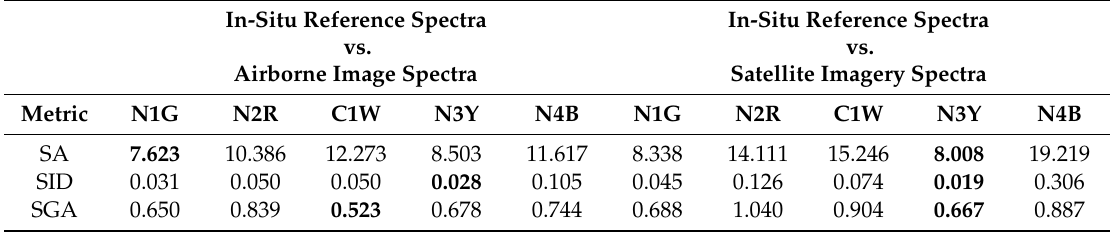
Table 2. Spectral similarity measures between the point-based in-situ target reference spectra and the corresponding airborne, and space-borne target image spectra (spectral angle (SA) is measured in degrees and spectral gradient angle (SGA) in radians) Values in bold are statistically significant.